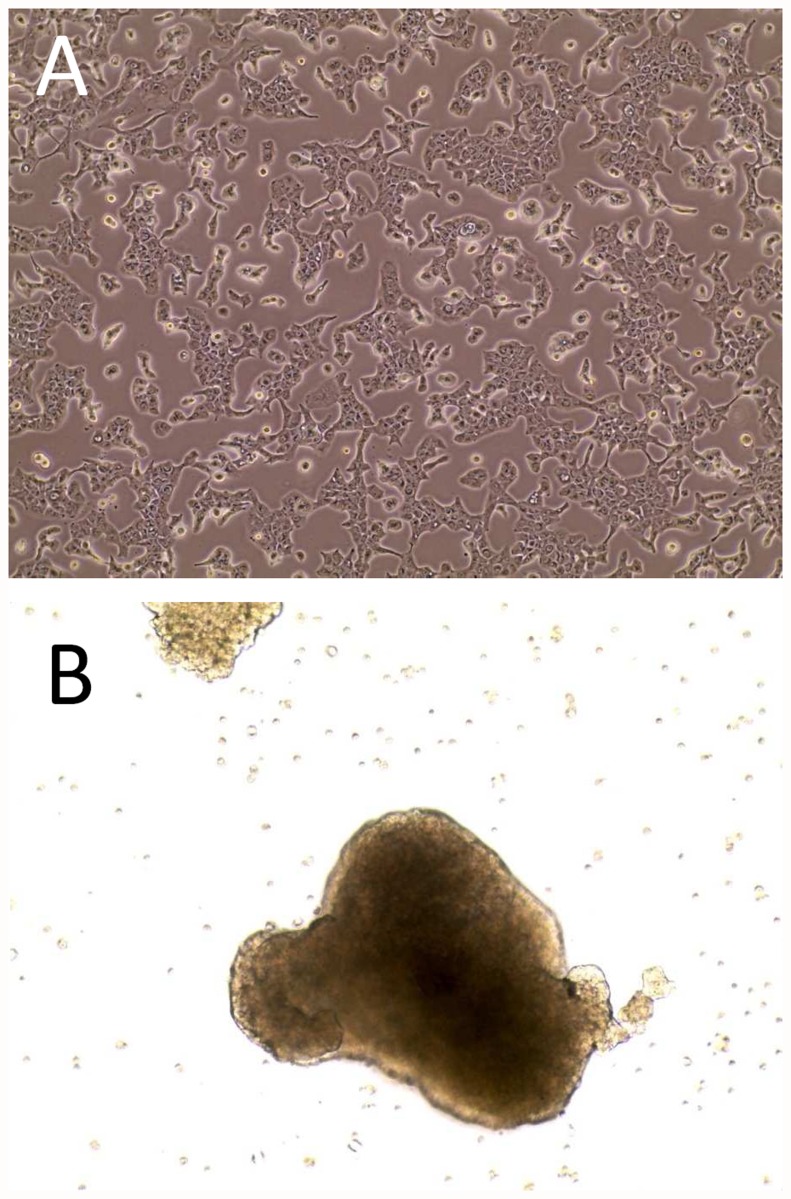
Morphology of cultures of the SK-ChA-1 cell line.Panel A, appearance of the adherent bidimensional culture and, Panel B, appearance of the MCTS (Multicellular Tumor Spheroids). In both instances cells were examined by phase contrast microscopy at 10x magnification.